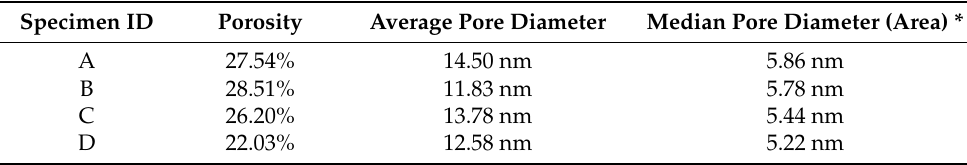
Figure 4. ( a ) Log differential and ( b ) cumulative intrusion/extrusion curve by pore size diameter of paste specimens after 28 days of curing. Table 2. Porosity of paste specimens after 28 days of